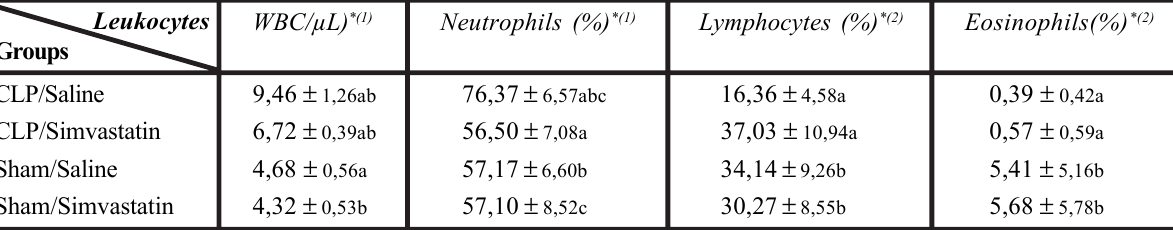
TABLE 1 - Number of WBC and percent of neutrophils, lymphocytes and eosinophils from the studied rats.